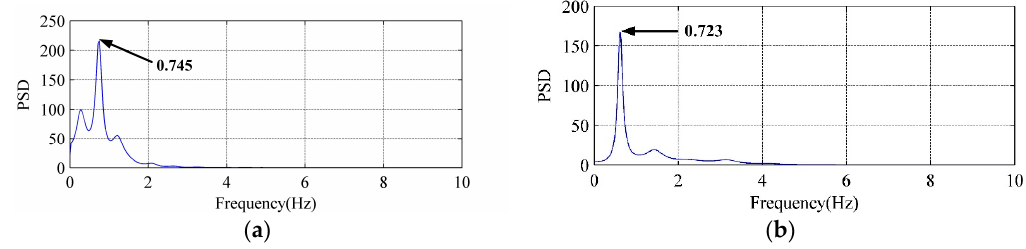
Figure 12. Comparison between vorticity monitoring data and prototype observation data of Condition 2: ( a ) Vorticity monitoring point B2; ( b ) LFN prototype observation point T11.